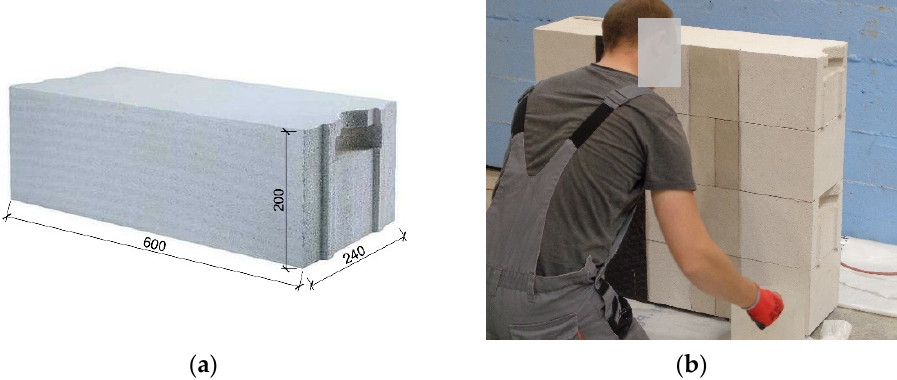
Figure 1. The view of element: ( a ) AAC block; ( b ) masonry wall before the application of strength- ening.